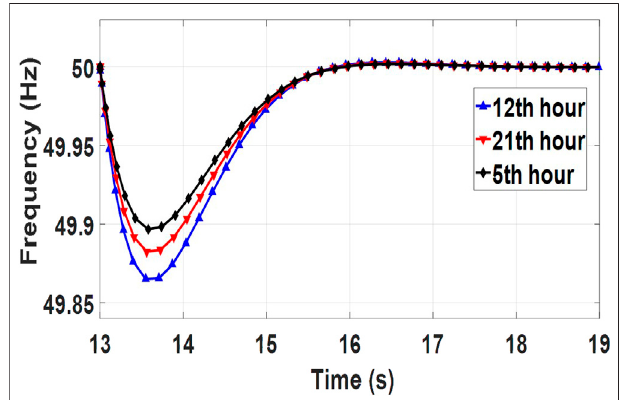
FIGURE 10 | Frequency Restoration in the fi fth, 12th, and 21st